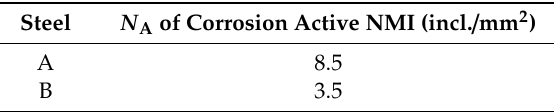
Table 3. Quantitative analysis of corrosion active non-metallic inclusions in hot rolled steels. NMI: non-metallic inclusions.